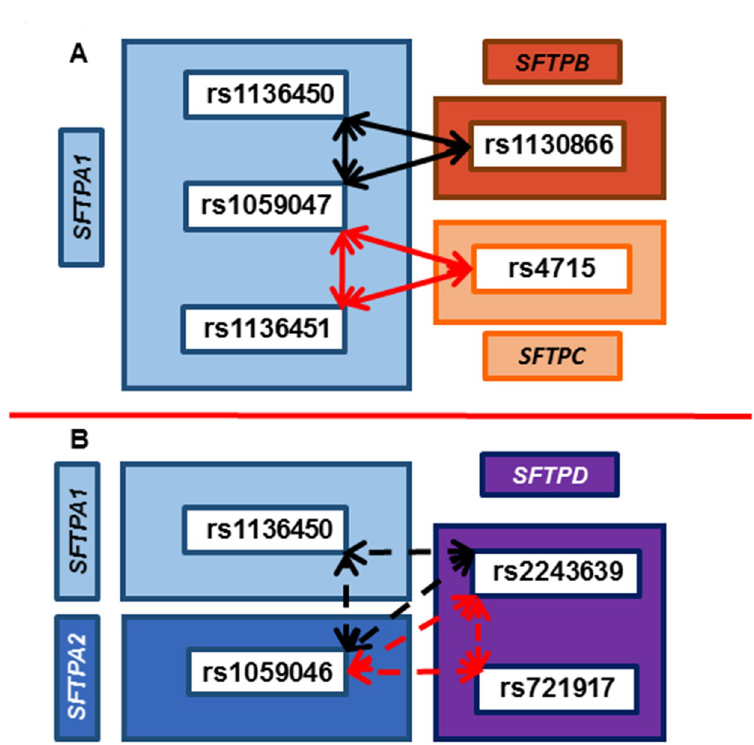
Figure 4. Association of SNP–SNP interactions of SP genes with PDAD. ( A ) shows interaction of SNPs of SFTPA1 , SFTPB , and SFTPC genes and ( B ) shows interaction of SNPs of hydrophilic SPs ( SFTPA1, SFTPA2 , and SFTPD ) alone. SP gene SNP–SNP interactions associated with PDAD compared to those who did not develop PDAD after adjusting for age, positive bacterial culture, and ventilator days. All interactions are intergenic and in a dominant form. In A, on the right, one SNP of the surfactant gene SFTPB and one SNP of the SFTPC gene, encoding the hydrophobic SP-B and SP-C, respectively, is shown within the dark and light orange rectangle, respectively. The SFTPA1 gene is shown in light blue on the left side. Solid arrows represent interactions between the hydrophilic SFTPA1 gene, and the hydrophobic SFTPB and SFTPC genes (d1 × d2 × d3 = rs1059047 × rs1136450 × rs1130866, p = 0.003–0.02, rs1059047 × rs1136451 × rs4715, p = 0.003–0.03). The odds ratio (OR) of less than one (0.4–0.6) indicates that both of these interactions associate with lower risk for PDAD. In B, the SFTPD gene is shown in purple on the right side. SFTPA1 and SFTPA2 genes are shown in light and dark blue, respectively, on the left side. Dotted arrows represent interactions among SNPs of the hydrophilic surfactant proteins, SFTPA2 , SFTPA1 , and SFTPD (rs1059046 × rs1136450 × rs2243639, p = 0.005–0.02, and rs1059046 × rs721917 × rs2243639, p = 0.00005–0.01, OR = 2.3). The OR of rs1059046 × rs1136450 × rs2243639 interaction is less than 1 (0.5–0.6), indicating that this interaction associate with lower risk for PDAD. In contrast, the OR of rs1059046 × rs721917 × rs2243639 interaction is more than 1 (1.9–2.3) indicating that this interaction is associated with increased susceptibility for